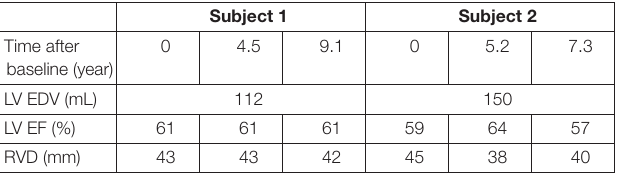
TABLE 2 | Patient characteristics of the two subjects at baseline and follow-up used in the likelihood